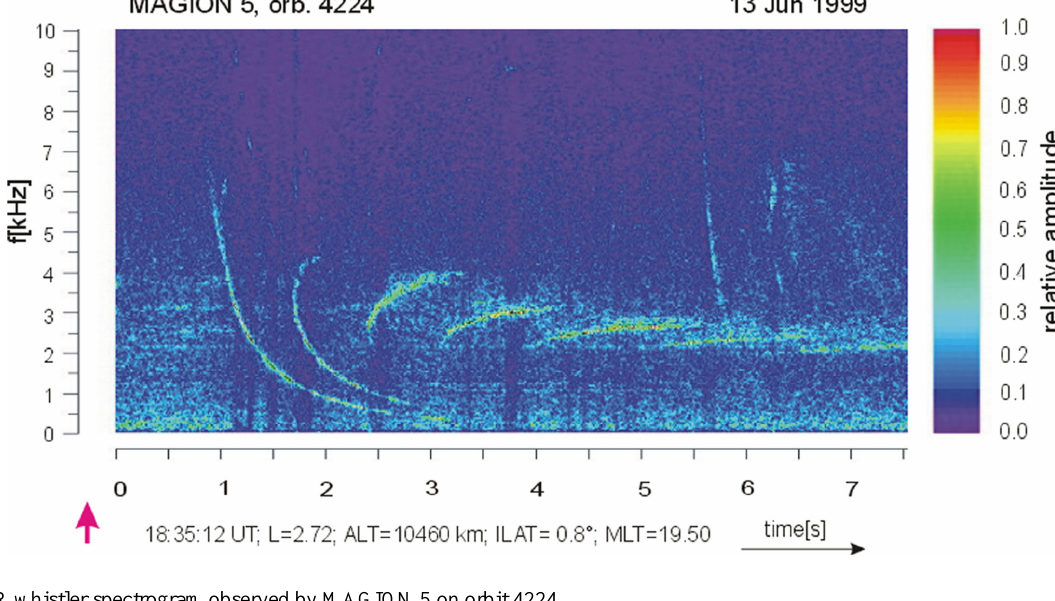
Fig. 6. MR whistler spectrogram observed by MAGION 5 on orbit 4224.